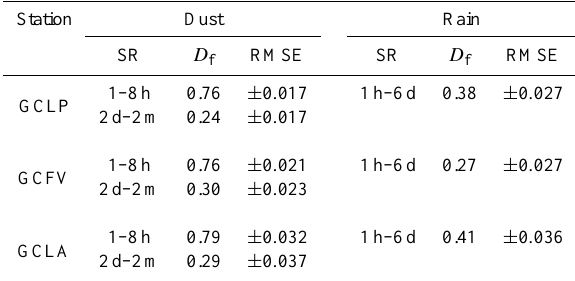
Table 2. Results of the box-counting analysis (scaling range, SR; fractal dimension, D f ; and associated RMSE) of the dust and rain event data series from hourly surface data in reference aerodromes for the period 1989–2010. (Scaling range is given in hours, h, days, d, and months,